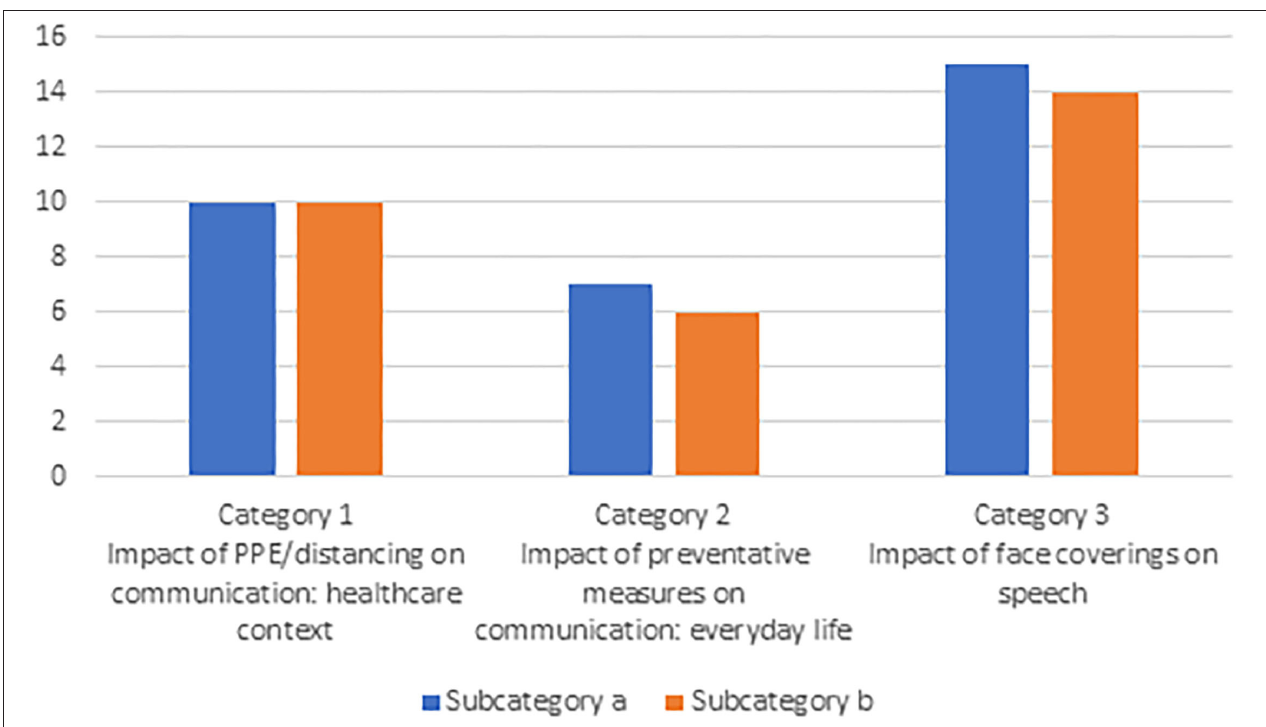
FIGURE 2 | Studies included in the scoping review per category and